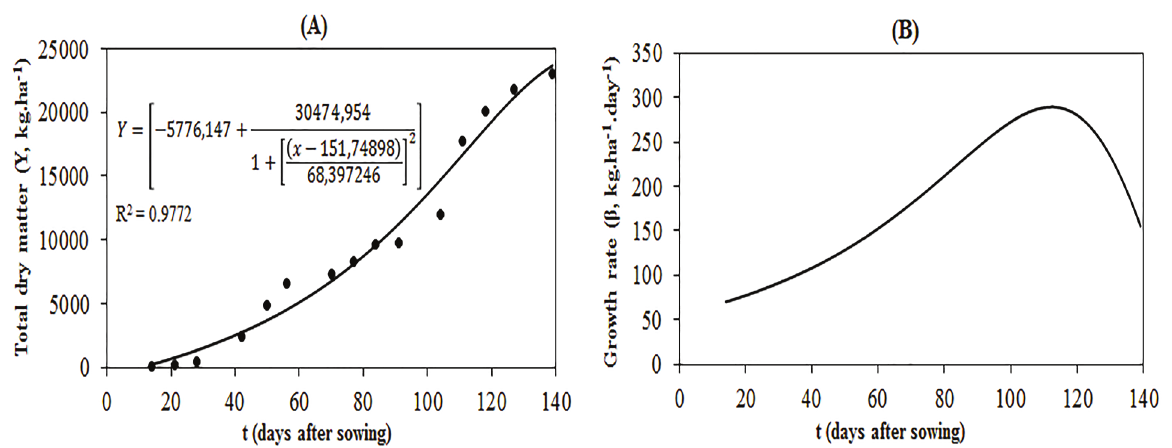
Figure 2 - Total dry matter (Y, kg.ha -1 ) (a) and growth rate (β, kg.ha -1 .day -1 ) (b) , of the maize crop (hybrid DKB 390 PRO 2), as a function of time (t, days after sowing - DAS). Piracicaba (SP),